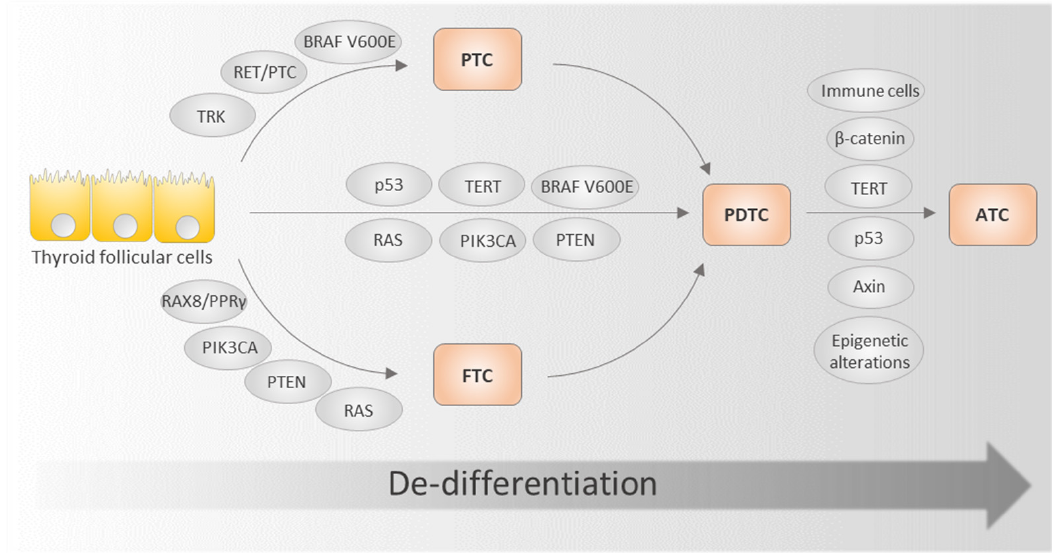
Figure 1. Schematic representation of TC progression showing critical genes and factors involved in de-differentiation. Modified from [29]. ATC, anaplastic thyroid carcinoma; FTC, follicular thyroid carcinoma; PDCT, poorly differentiated thyroid carcinoma; PTC, papillary thyroid carcinoma.